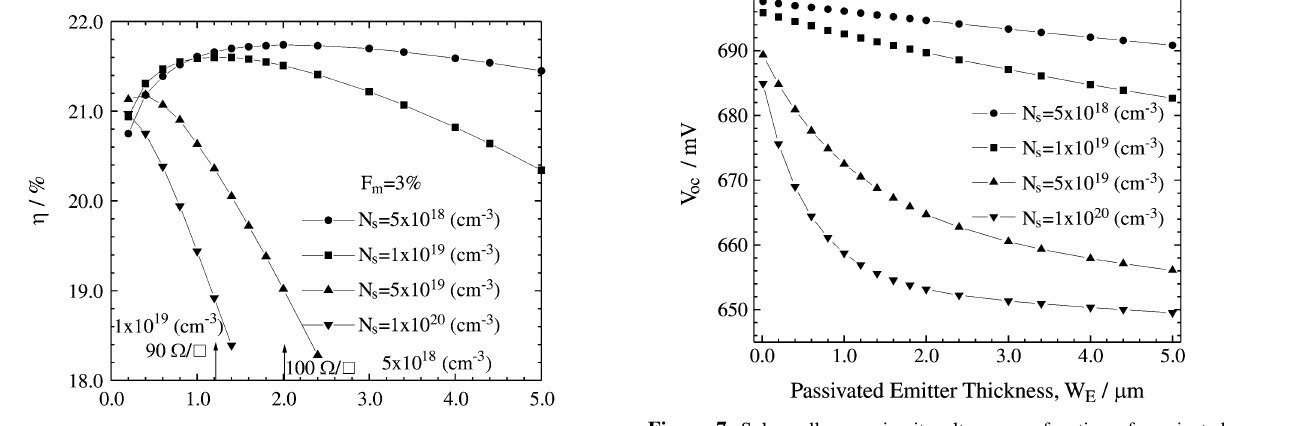
Figure 7. Solar cell open-circuit voltage as a function of passivated emitter thickness (W E ), considering different doping levels (metal grid shadowing factor F m = 3%).